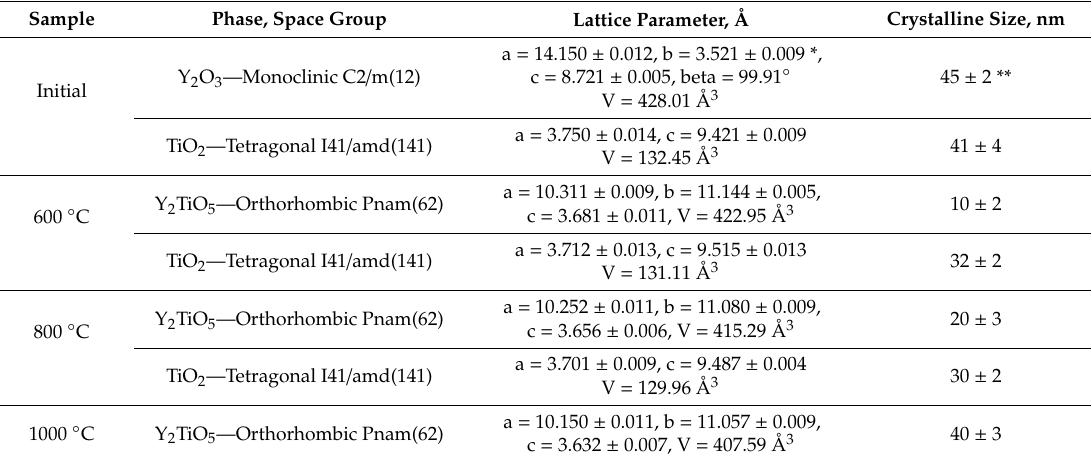
Figure 3. Dynamics of phase transformations of nanostructured ceramics Y 2 O 3 /TiO 2 -Y 2 TiO 5 doped Figure 3. CNTs. Table 2. Data of structural parameters. Table 2. Data of structural parameters